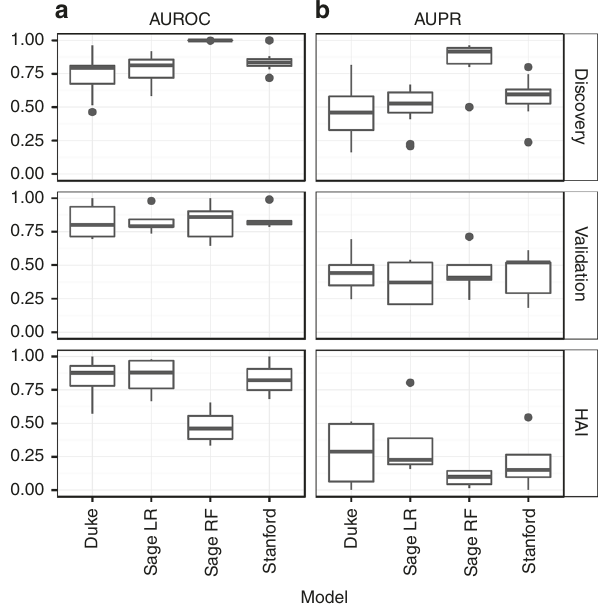
Fig. 2 Model performance of the four genomic mortality predictors as measured by ( a ) AUROC and ( b ) AUPRC. The three panels (top, middle, bottom) show boxplots of the performance across all Discovery,